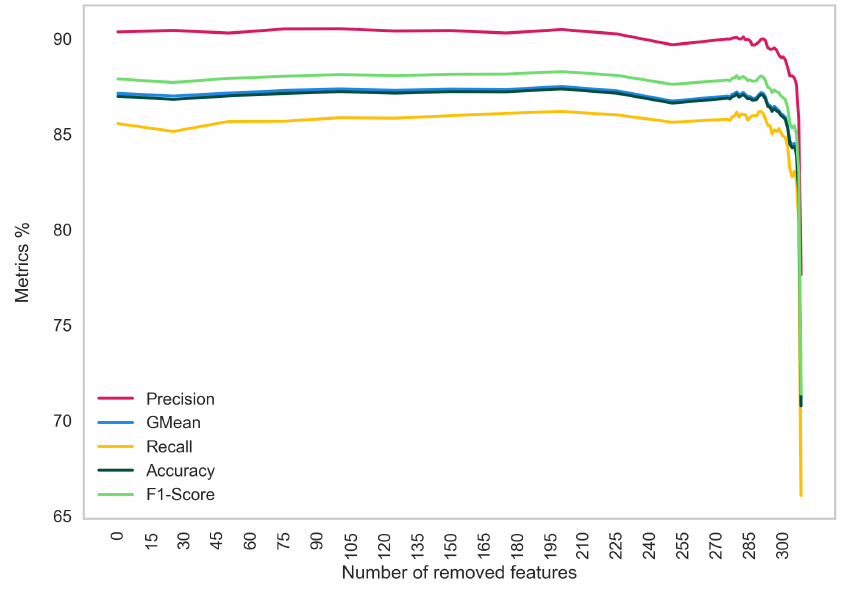
Figure 6. Performance of the BBC classifier for the pruned-features dataset. The x-axis corresponds to the number of features removed in every iteration starting from the least important ones and moving towards the most important. We observe that the performance remains the same, even if we remove more than half of the total